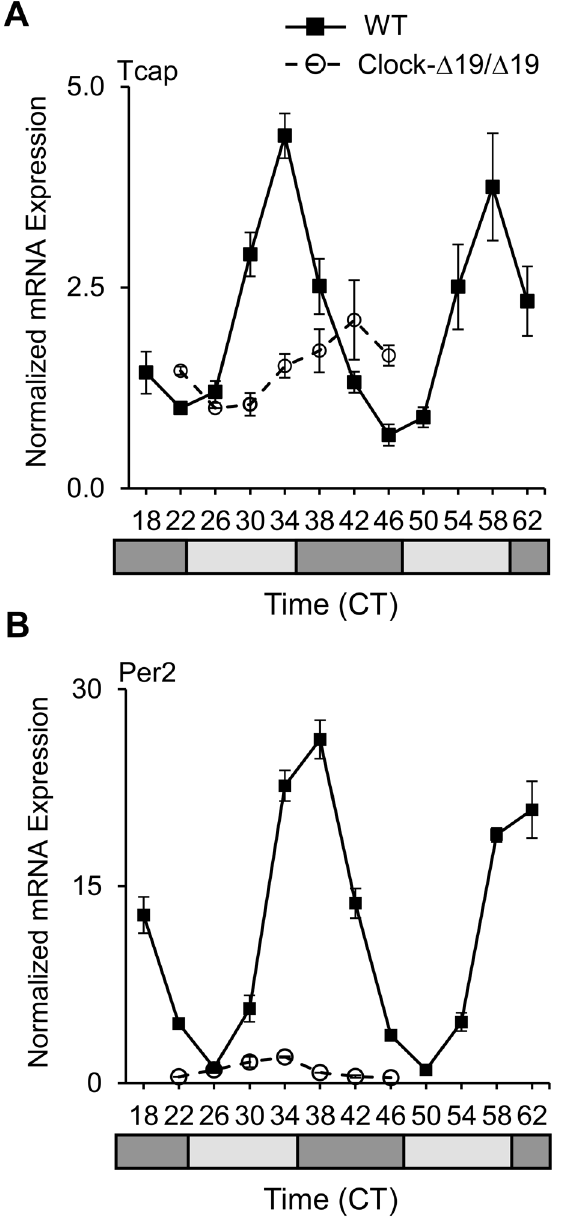
Figure 3. Circadian rhythms in Tcap and Per2 mRNA expression in WT hearts, and blunted expression levels and amplitude in Clock D 19/ D 19 heart. Starting at 30 h after transfer into D:D (CT=18) the mice were euthanized, and hearts collected every 4 h from the Clock D 19/ D 19 ( # ) and WT ( & ) littermate mice (n=4/time point). Rhythmic expression of ( A ) Tcap mRNA (JTK_Cycle, p=1.09 6 10 2 7 ), and ( B ) Per2 mRNA (positive control; JTK_Cycle, p=1.18 6 10 2 9 ) in WT hearts. In contrast in Clock D 19/ D 19 hearts, gene expression is barely periodic and amplitude is severely blunted consistent with being target genes. The circadian environment of 12 h dark (black bars, animal’s subjective wake time) and 12 h dark (grey bars, animal’s subjective sleep time) is illustrated by the bars below the graphs.